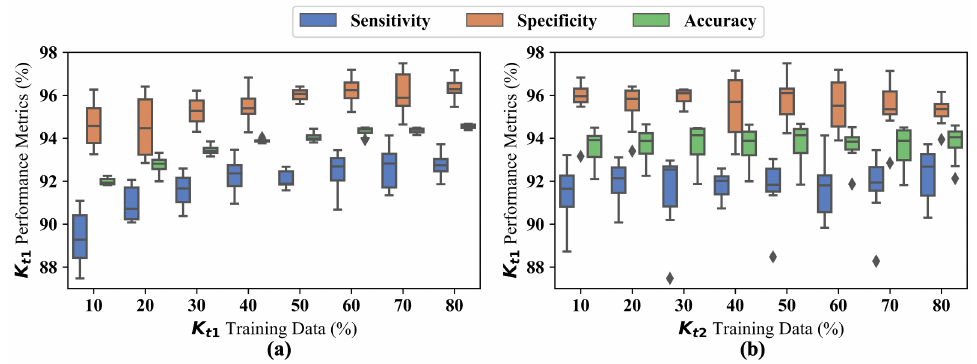
Figure 13. Distributions of the sensitivity, specificity, and accuracy of the K t 1 test data with variations in the training data percentages for ( a ) K t 1 and ( b ) K t 2 . The center lines in the boxplots represent the median, and the outliers are shown with diamonds.